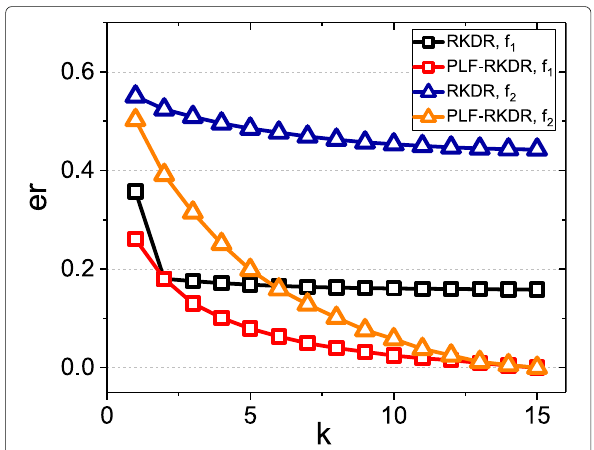
Fig. 1 The relative error of RKDR algorithm and PLF-RKDR algorithm on the simulation dataset